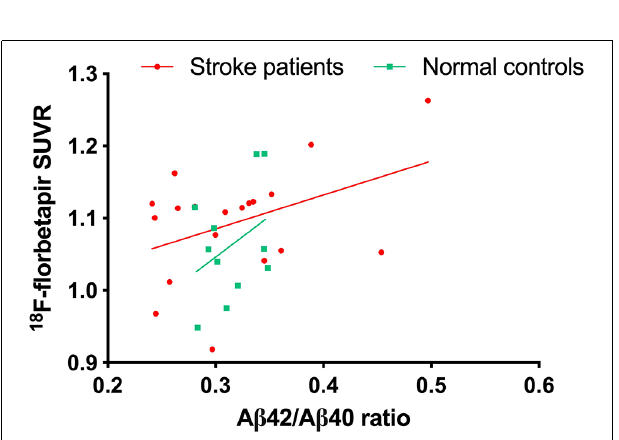
FIGURE 3 | The correlation between plasma A β 42/A β 40 ratio and cortical amyloid accumulation burden on 18 F-florbetapir PET. Similar findings were also noted in previous studies. Tau